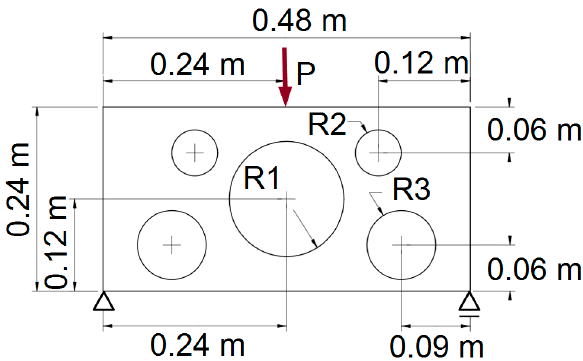
Figure 31. The initial structure with applied loads and supports.